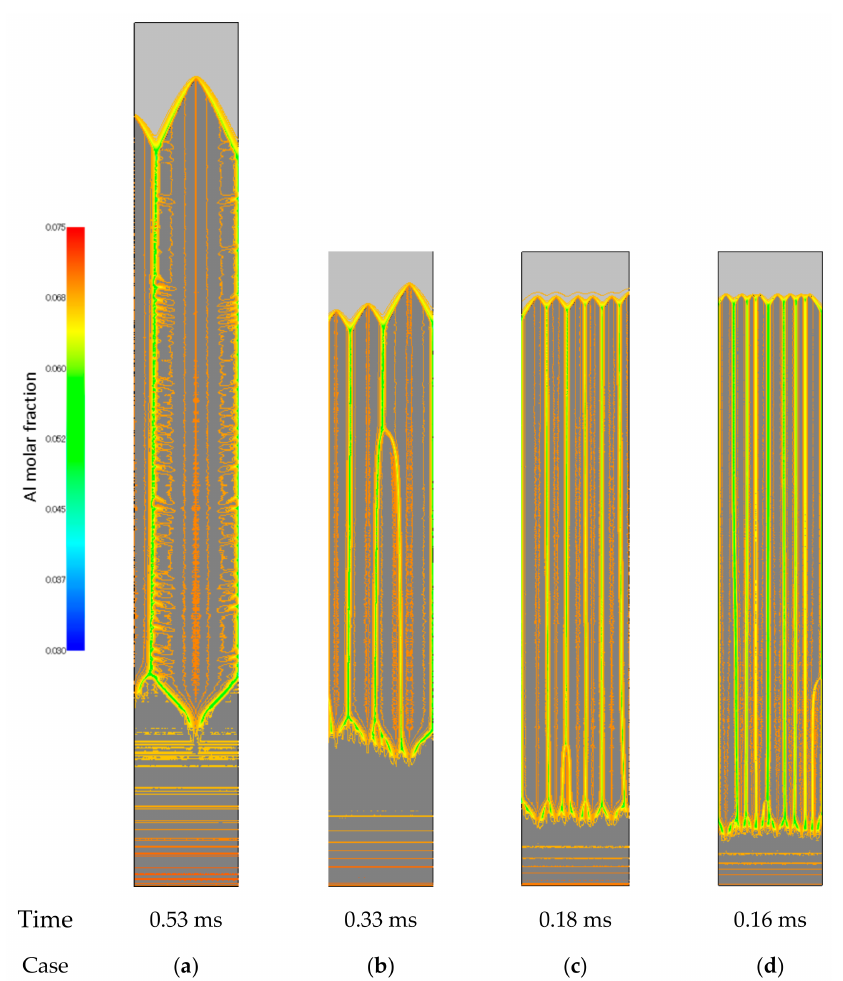
Figure 9. Snapshots of solidification microstructure distributions obtained by the non-equilibrium MPFM at Al concentration (molar fraction) at ( a ) 5 × 10 5 K/s and 5 × 10 6 K/m, ( b ) 1 × 10 6 K/s and